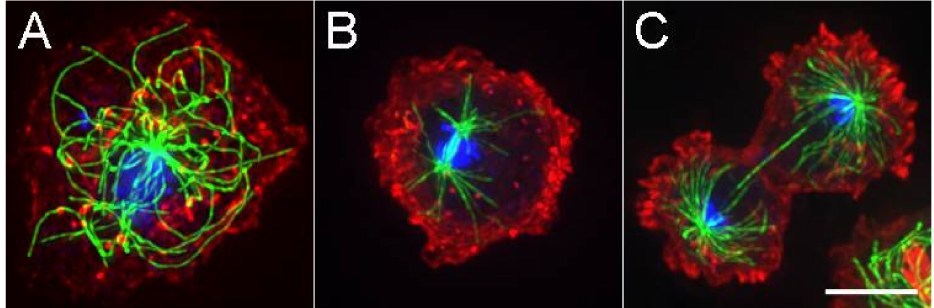
Figure 1. Microtubules (MTs) in D. discoideum . ( A ). Interphase cell with radially arranged MTs (in green) emanating from a centrally located centrosome. DNA is in blue, actin in red. Panels ( B ) and ( C ) show anaphase and late telophase views of mitotic spindle assemblies. While the spindle MTs are contained within a semi-closed nuclear compartment, astral MTs project off into the cytoplasm. Scale bar = 5 µ